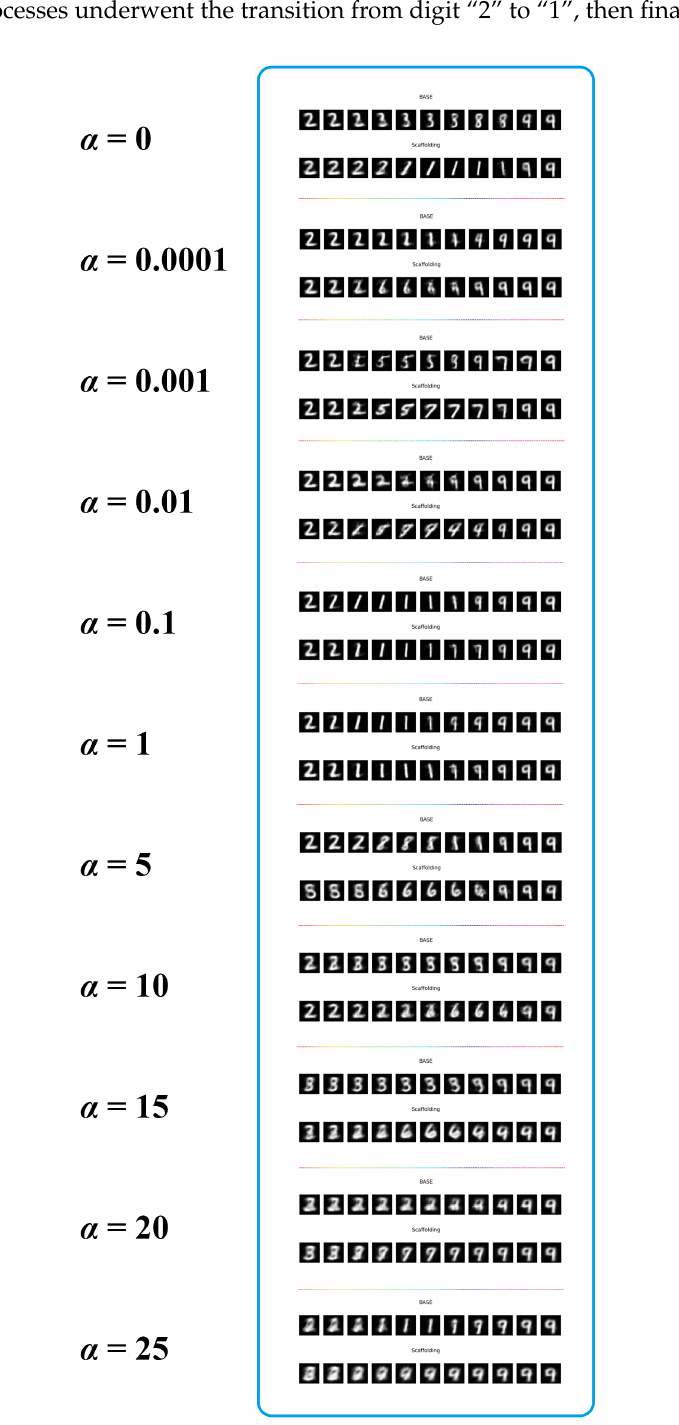
Figure 3. α -wise linear interpolation of latent spaces of base and scaffolding VAEs in EVAE on MNIST dataset. For comparative purposes, we fixed the start and end digits to be “2” and “9”, respectively. For each α , we linearly interpolate the latent spaces of the two-component VAEs in EVAE to observe their entire digit-transformation